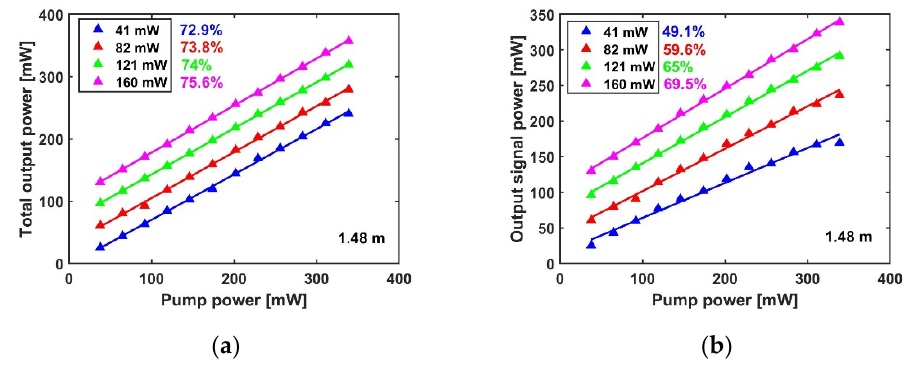
Figure 6. The variation of ( a ) total output power and ( b ) output signal power with pump power. Pump thresholds with seed powers from 41 mW to 160 mW: 53.2 mW; 67.2 mW; 69.8 mW; 76.8